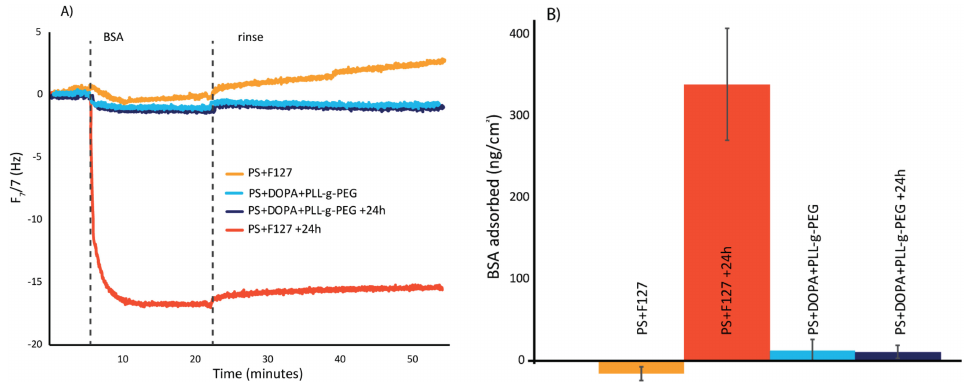
Figure 2. Testing the modified surface's response to BSA with or without pre-soaking in buffer for 24 h. Introduction of BSA and start of rinse is indicated by the dotted lines in ( A ). Average and standard deviation of adsorbed BSA mass (calculated using the Sauerbrey equation) presented in ( B